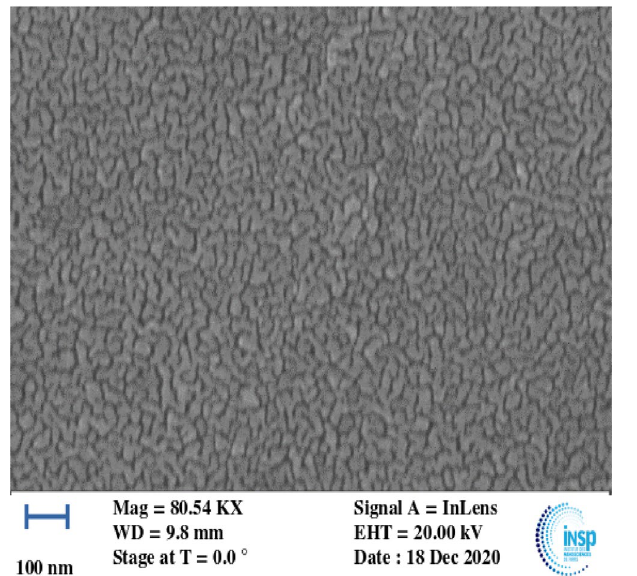
Figure 2. SEM images of the surface of from Au/Al